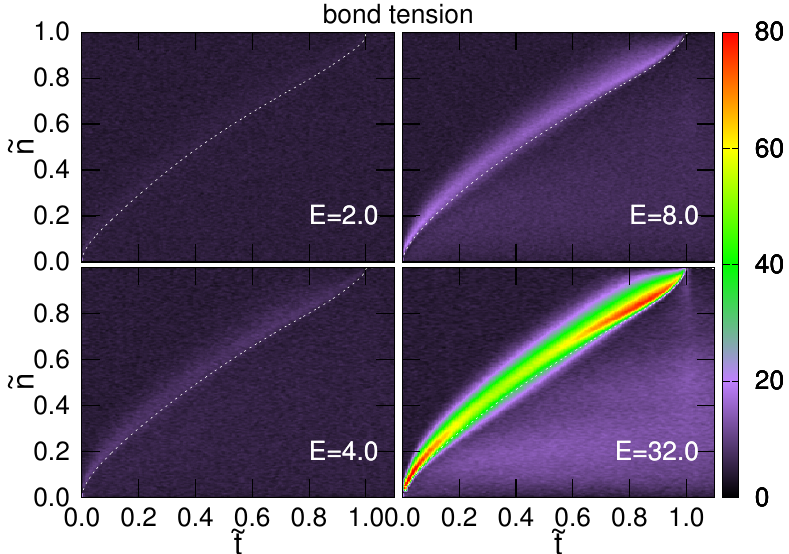
Figure 5. Intensity plots of the bond tension (cid:104) f n (cid:105) in the scaled ˜ t -˜ n space for N = 256 at four field strengths E (indicated in the figures). The strength of tension is represented by color, and the color scale is given at the right of the figure. The dashed line shows the scaled translocation coordinate (cid:104) ˜ s (cid:105) , which depicts the progress of